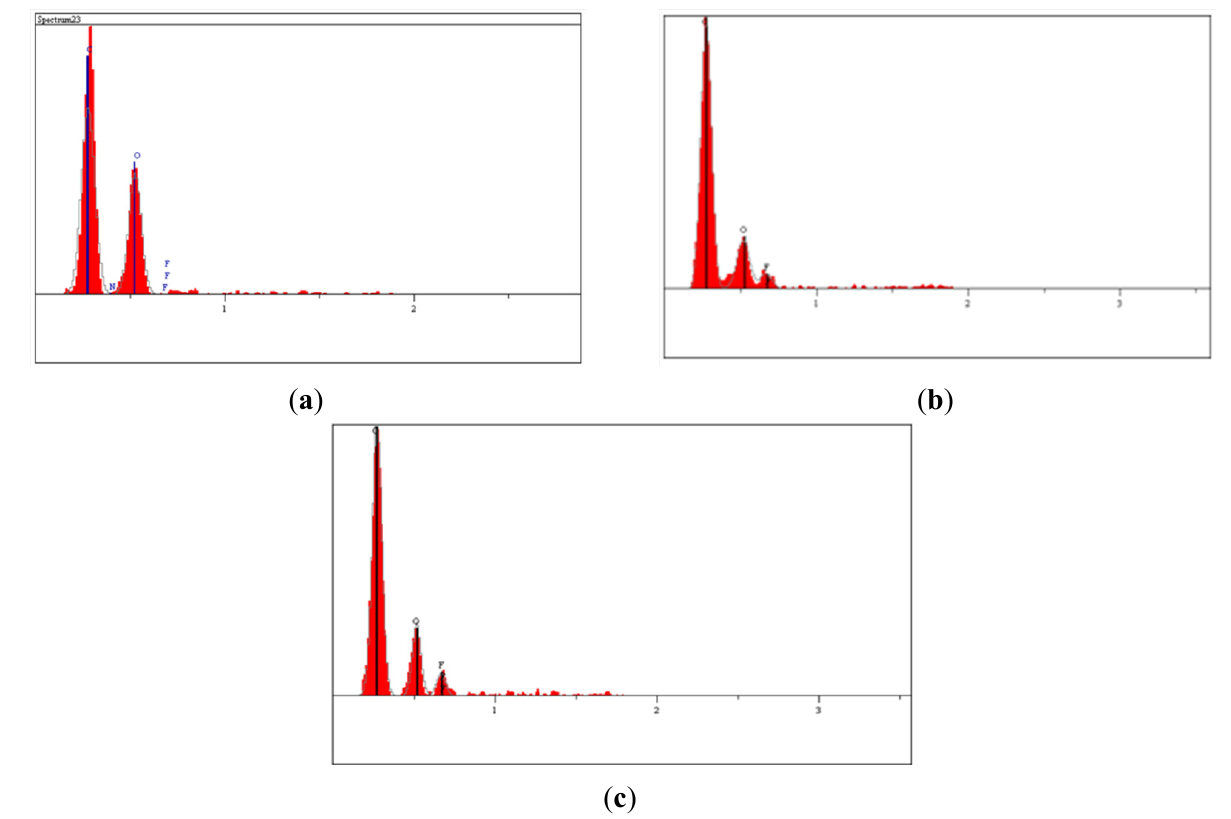
Figure 3. Energy dispersive spectroscopy (EDS) spectrum of: ( a ) untreated fiber ( b ) treated fiber with PA1 ( c ) treated fiber with